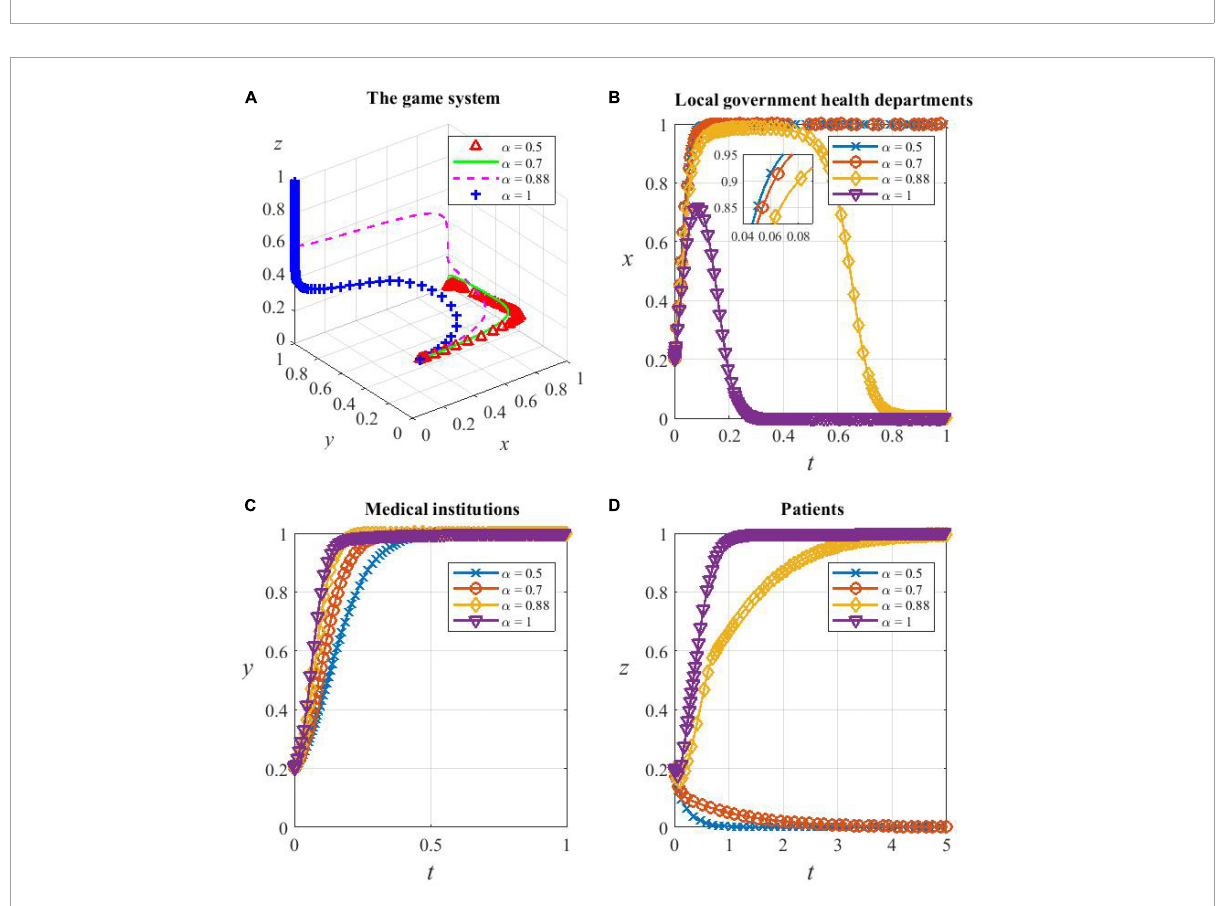
FIGURE9 The game subjects’ sensitivity to α . (A) The whole game system’s sensitivity to α , (B) local government health departments’ sensitivity to α , (C) medical institutions’ sensitivity to α , and (D) patients’ sensitivity to α